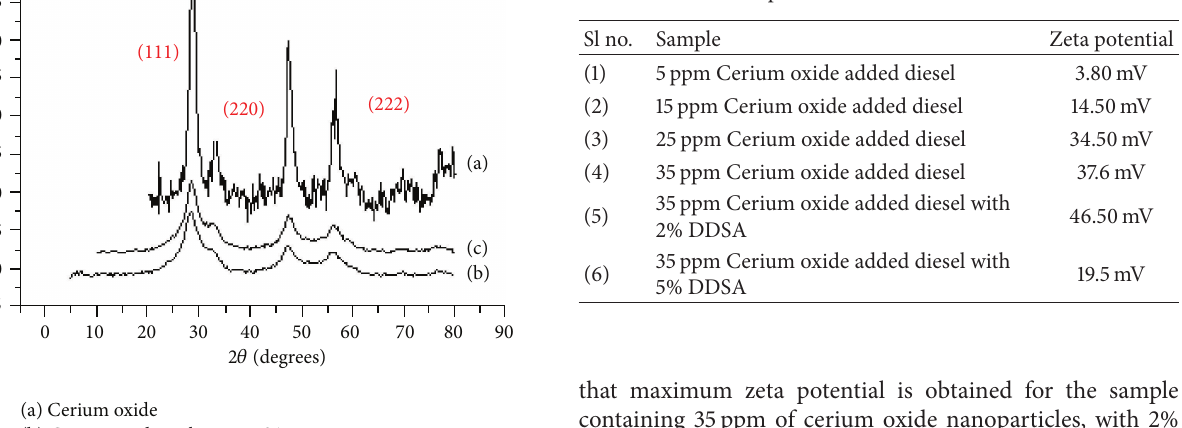
Table 2: Zeta potential values of modified diesel